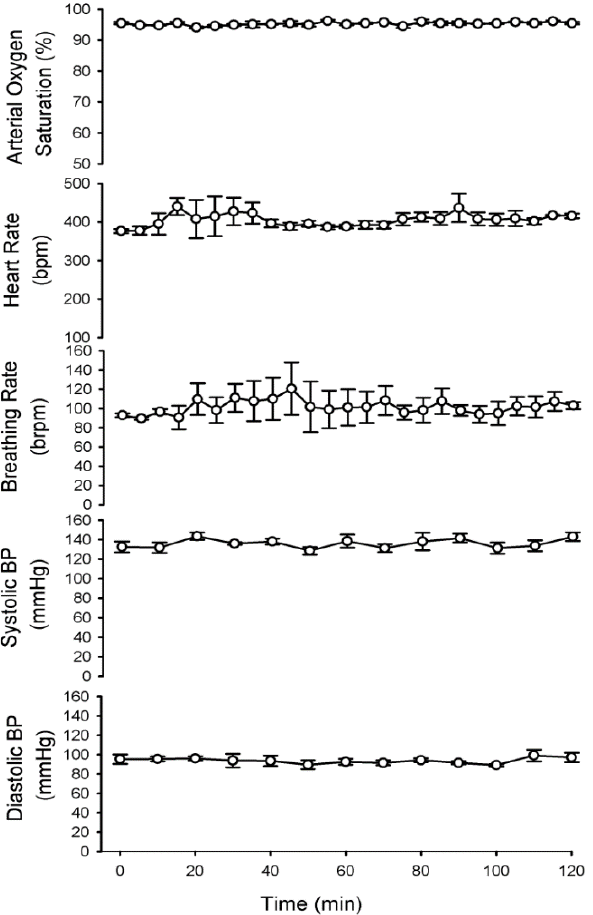
Figure 1. Propofol infusion did not cause significant disturbances in the vital signs of pregnant rats. Arterial oxygen saturation, heart rate and breathing rate were monitored by pulse oximeter. The data were averaged every 5 min during propofol exposure. Blood pressure was measured every 10 min by non-invasive blood pressure system. These data indicated no significant differences in any of the measured parameters compared to the baseline (0 h) ( N = 6).